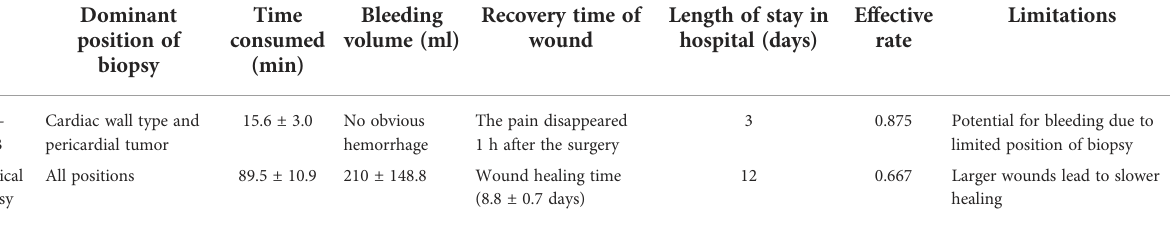
TABLE 4 Differences between PUS-CNB and surgical resection.